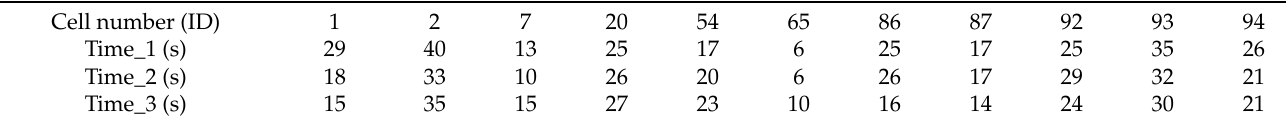
Table 6. The deviations of 12 mV from the average, during the three